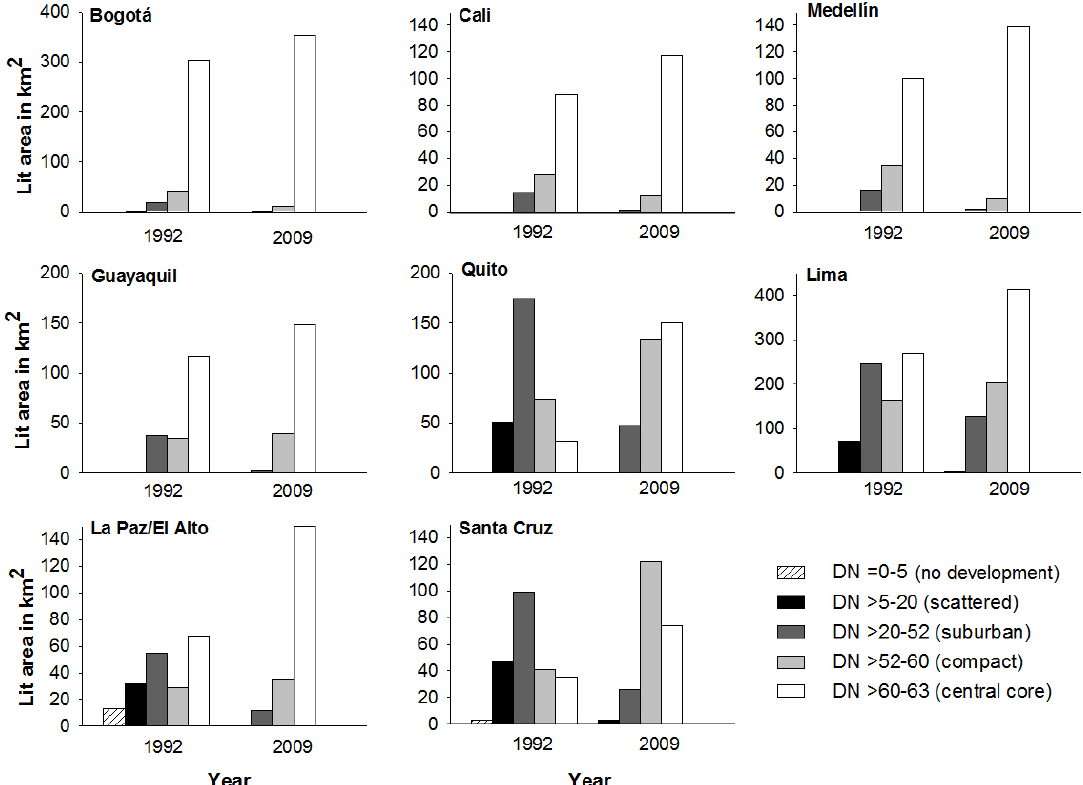
Figure 4. Change in the distribution of the night-time lights (NTL) classes between 1992 and 2009 within the city